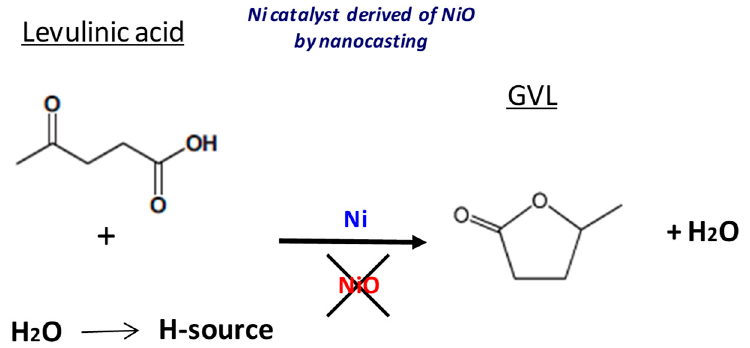
Figure 9. Scheme showing a summary of the experiments carried out in this work.